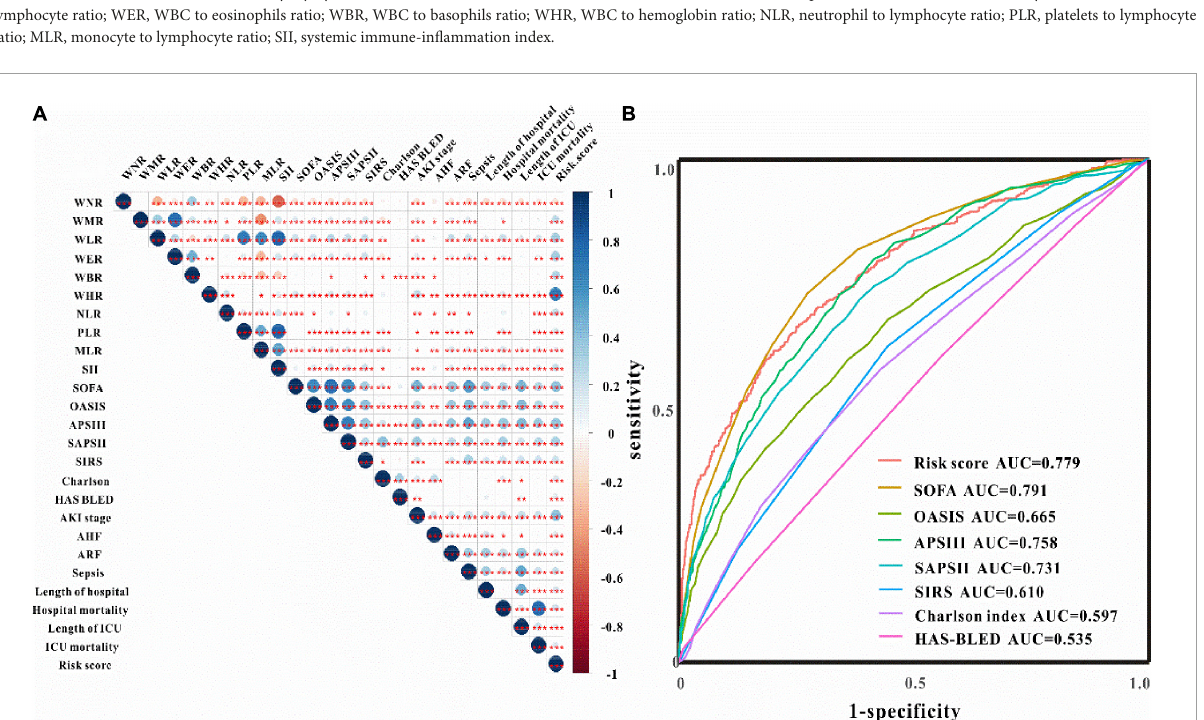
higher WBC counts, BUN, creatinine, and potassium, and lower hemoglobin, platelet, albumin, and bilirubin compared to the non-AKI group in both training and validation sets ( P < 0.05 for all comparisons, Table 1